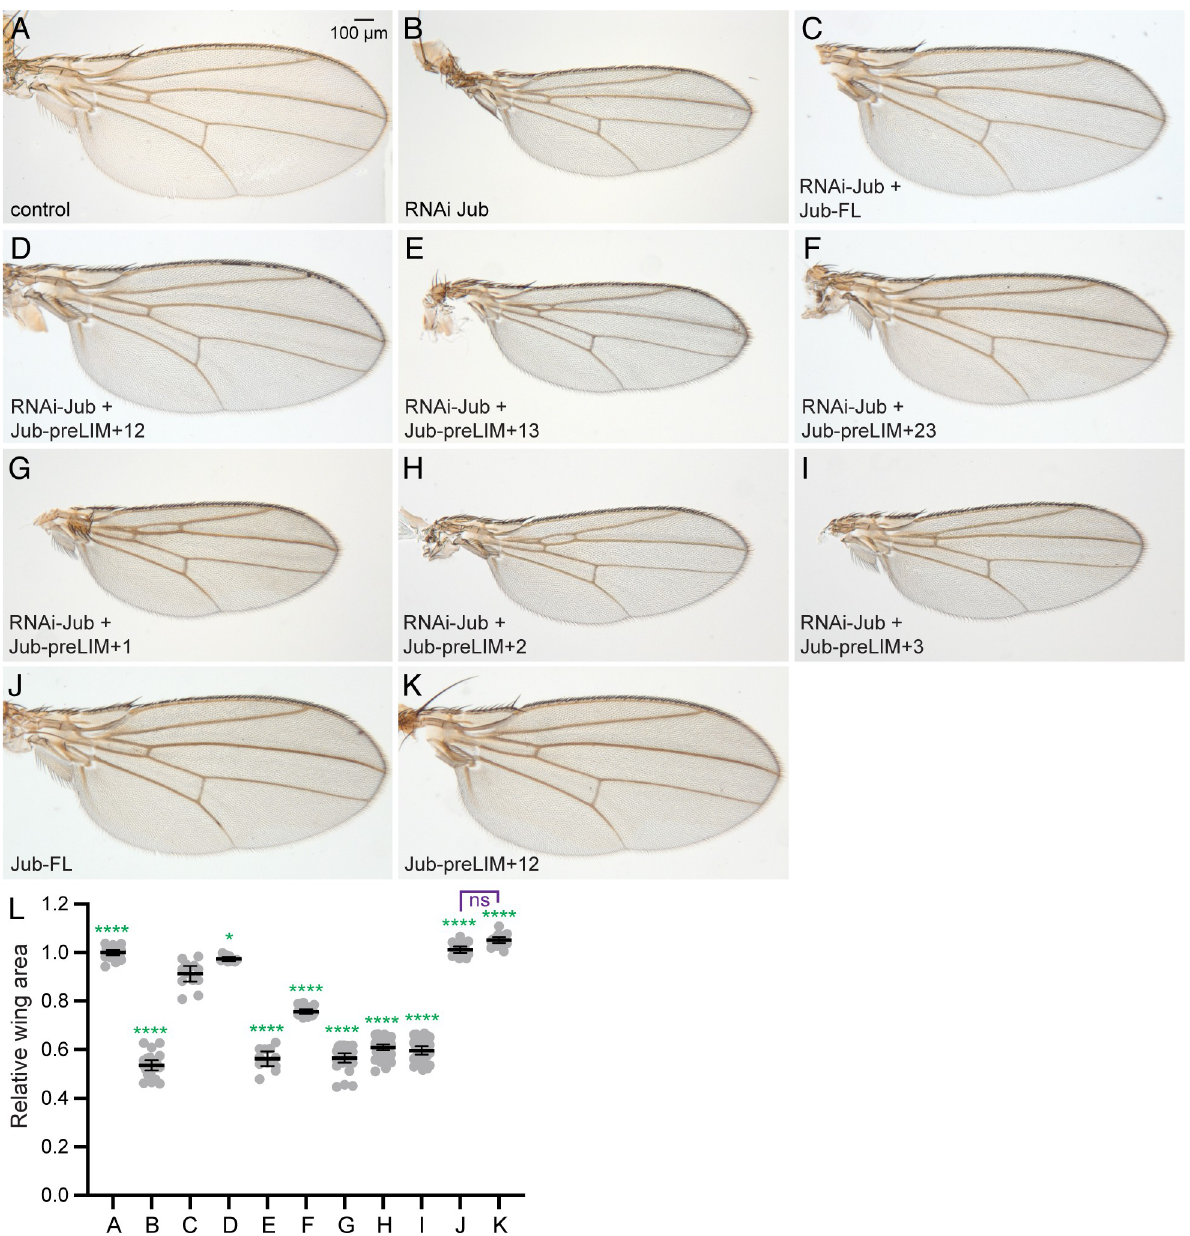
Fig 2. Rescue of adult wings by Jub deletion constructs. A-K) Representative adult wings from male flies expressing nub-Gal4 UAS-Dcr2 and A) control. B) UAS-RNAi-jub . C) UAS-RNAi-jub UAS-Jub-FL : msVenus . D) UAS-RNAi-jub UAS-Jub-preLIM+12 : msVenus . E) UAS-RNAi jub UAS-Jub- preLIM+13 : msVenus . F) UAS-RNAi jub UAS-Jub- preLIM+23 : msVenus . G) UAS-RNAi jub UAS-Jub- preLIM+1 : msVenus . H) UAS-RNAi jub UAS-Jub- preLIM+2 : msVenus . I) UAS-RNAi jub UAS-Jub- preLIM+3 : msVenus . J) UAS-Jub-FL : msVenus . K) UAS-Jub-preLIM+12 : msVenus . All wings are shown at the same magnification (scale bar = 100 μ m). L) Scatter plot showing quantitation of wing area, normalized to the mean wing area in control flies, with mean and 95% ci indicated by black bars. Letters identify the genotypes as in the panels above, number of wings measured is A) 21, B) 22, C) 13, D) 10, E) 11, F) 18, G) 29, H) 43, I) 31, J) 17, K) 17. The significance of differences in expression levels as compared to UAS-RNAi-jub UAS-Jub-FL : msVenus are indicated by green asterisks, comparison between J and K is indicated in purple. whereas Jub-preLIM+12 fully rescued ex-lacZ expression (Fig 3C–3F). ex-lacZ expression in Jub-preLIM+23 was slightly above that detected in Jub-preLIM+13 wing disc cells. To further assay the ability of these constructs with two LIM domains to rescue Yki activity in jub RNAi